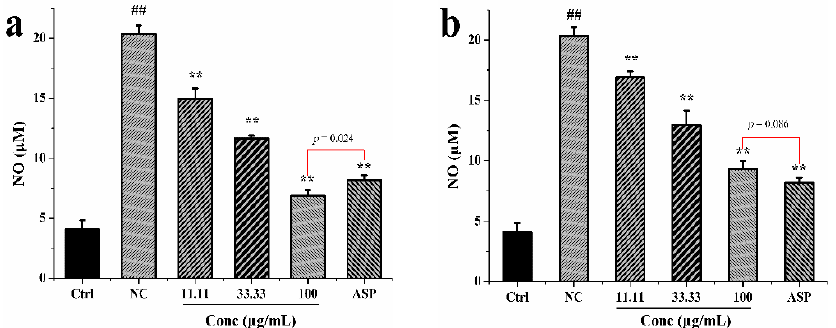
Figure 1. Anti-inflammatory activities of leaves ( a ) and seeds ( b ) of M. oleifera on NO production in RAW264.7 cells. ** p < 0.01, compared with the NC (negative control) group.